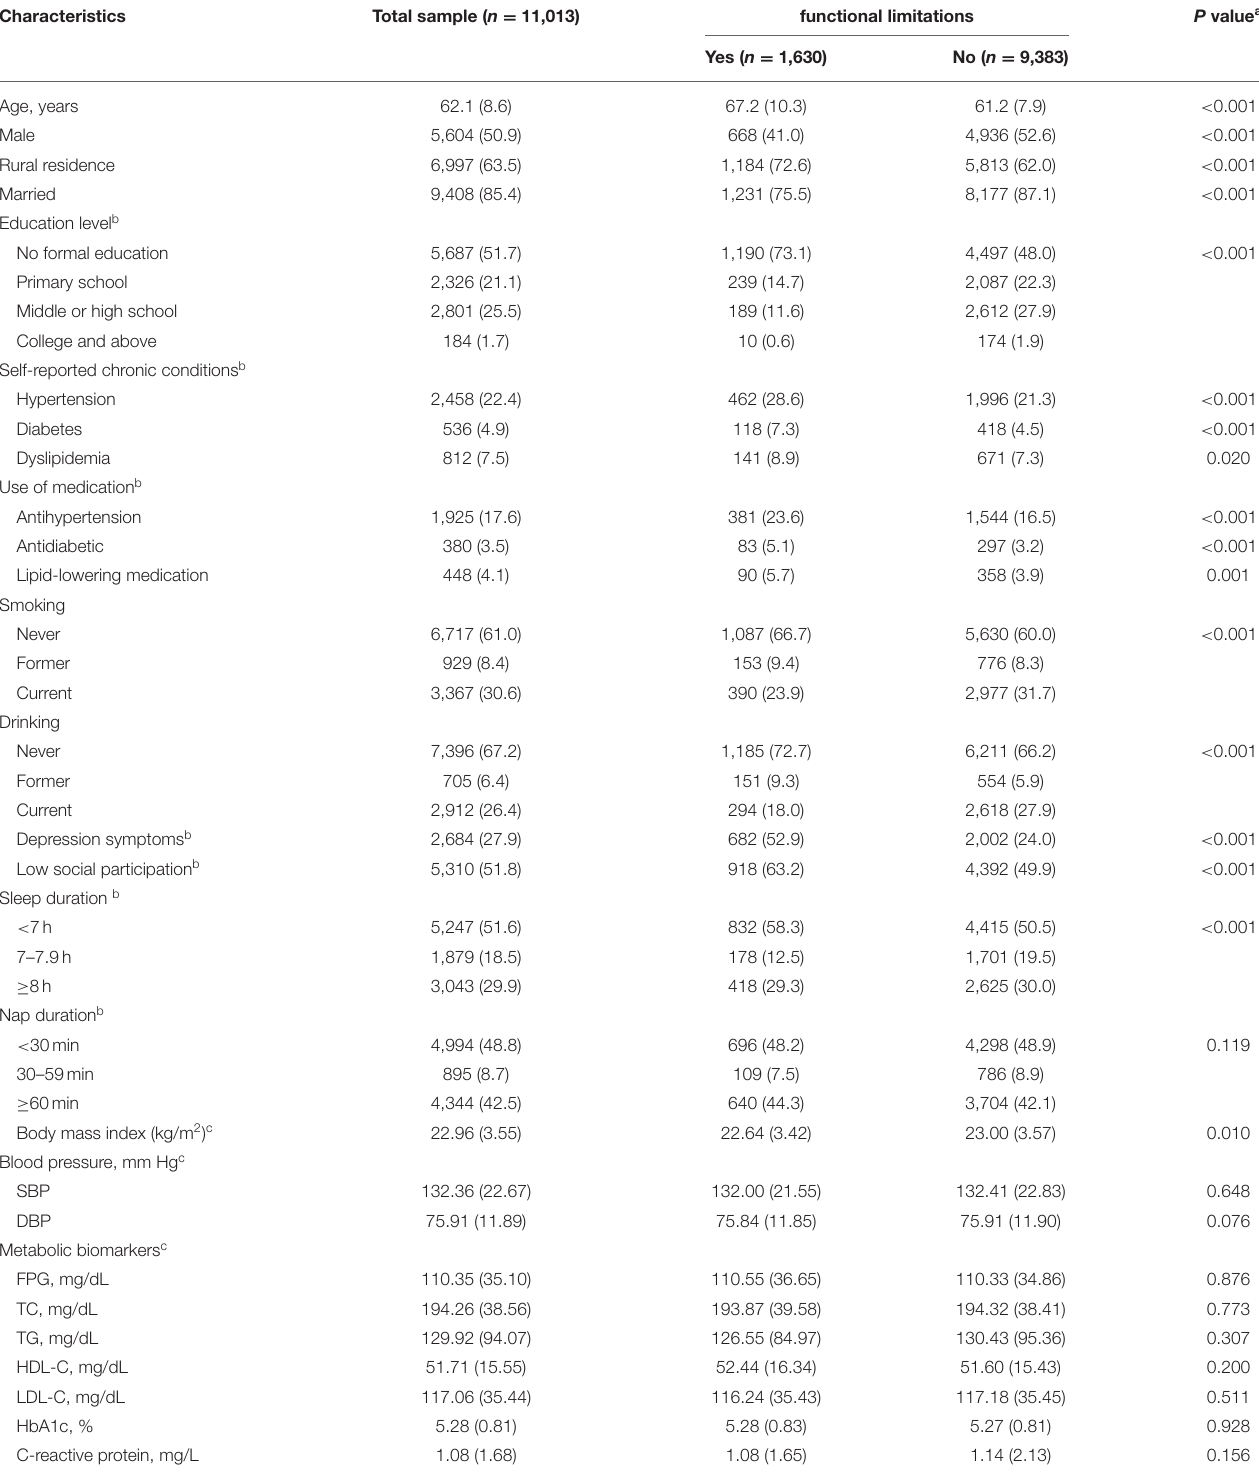
TABLE 1 | Characteristics of participants at baseline according to functional status.